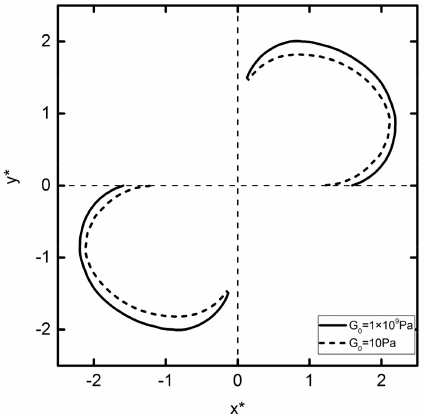
Figure 8. Trajectories of two particles initially located with θ = 85 ◦ and R * = 3 subjected to an external electric field E ∗ = 0.05. The solid lines and dashed lines represent G 0 = 1 × 10 9 Pa and G 0 = 10 Pa,